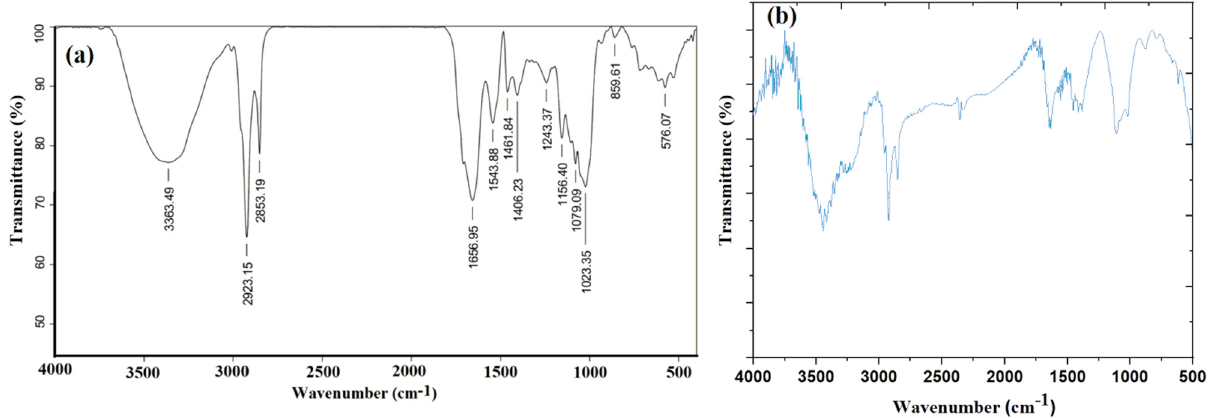
Figure 2: ( a ) FTIR of pumpkin seeds ’ extract and ( b ) FTIR of ZnO NPs derived from the extract of pumpkin seeds.